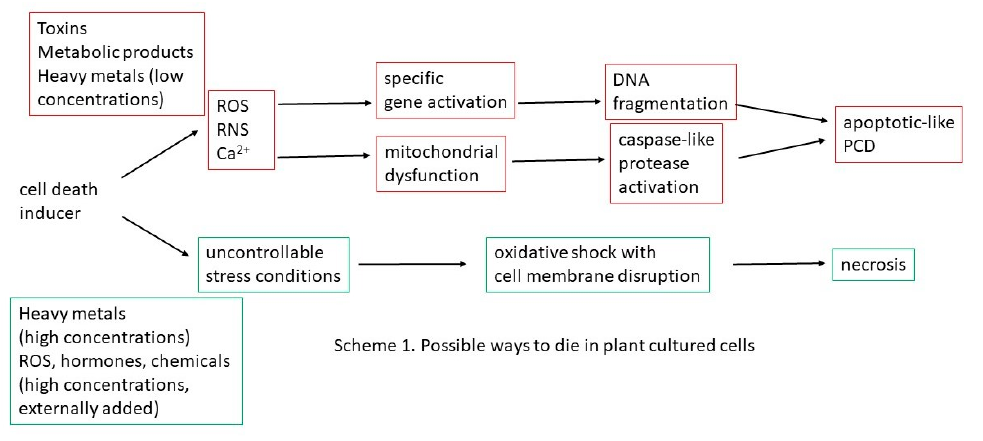
Scheme 1. Possible ways to die in plant-cultured